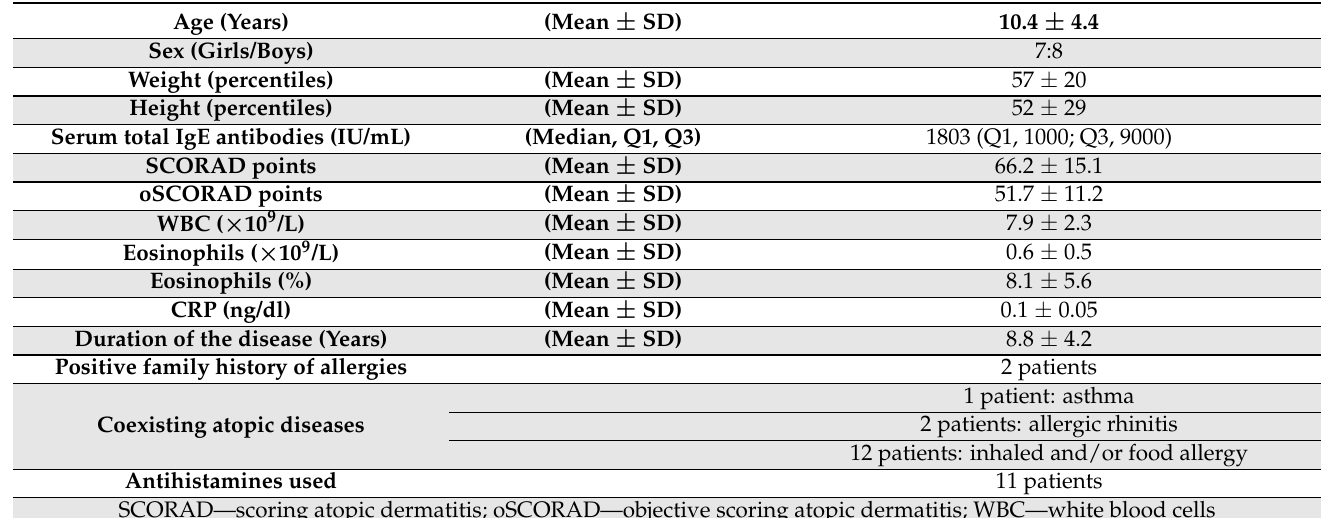
Table 2. Characteristics of the study group.